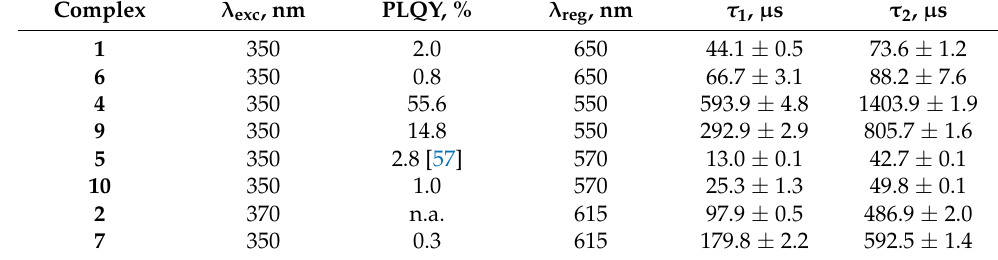
Table 3. PL quantum yields and PL decays characteristic lifetimes for Sm, Tb, Dy and Eu complexes.